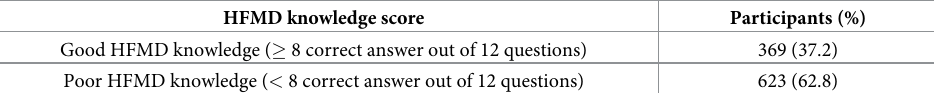
Table 3. HFMD knowledge score of participants in study of knowledge of HFMD and acceptability of EV71 vac- cine among parents of under-five in Chongqing, China.